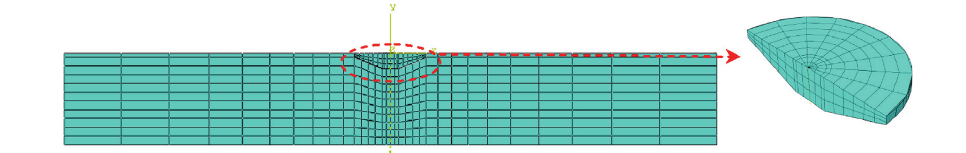
Figure 16: Finite element model.